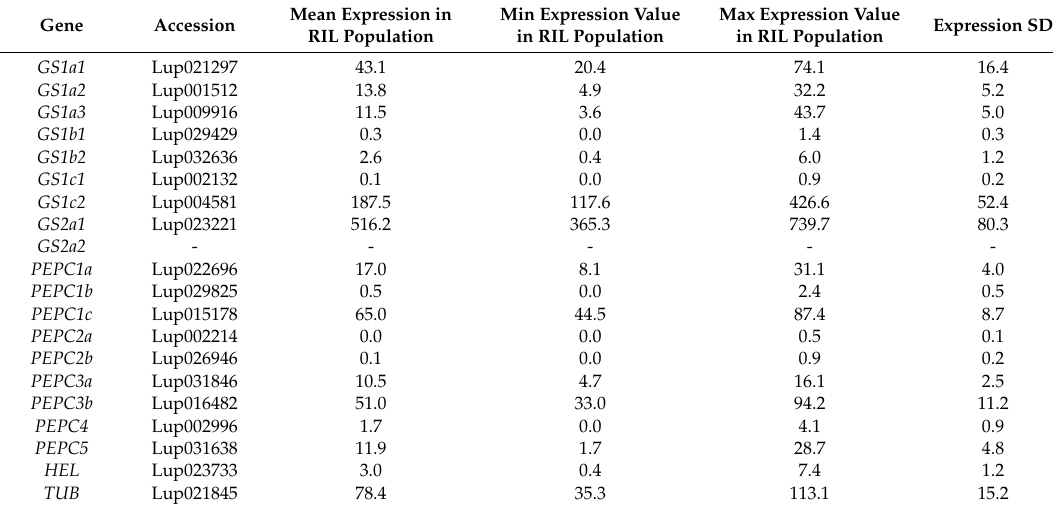
Table 4. Normalized leaf expression level of GS and PEPC genes in a L. angustifolius recombinant